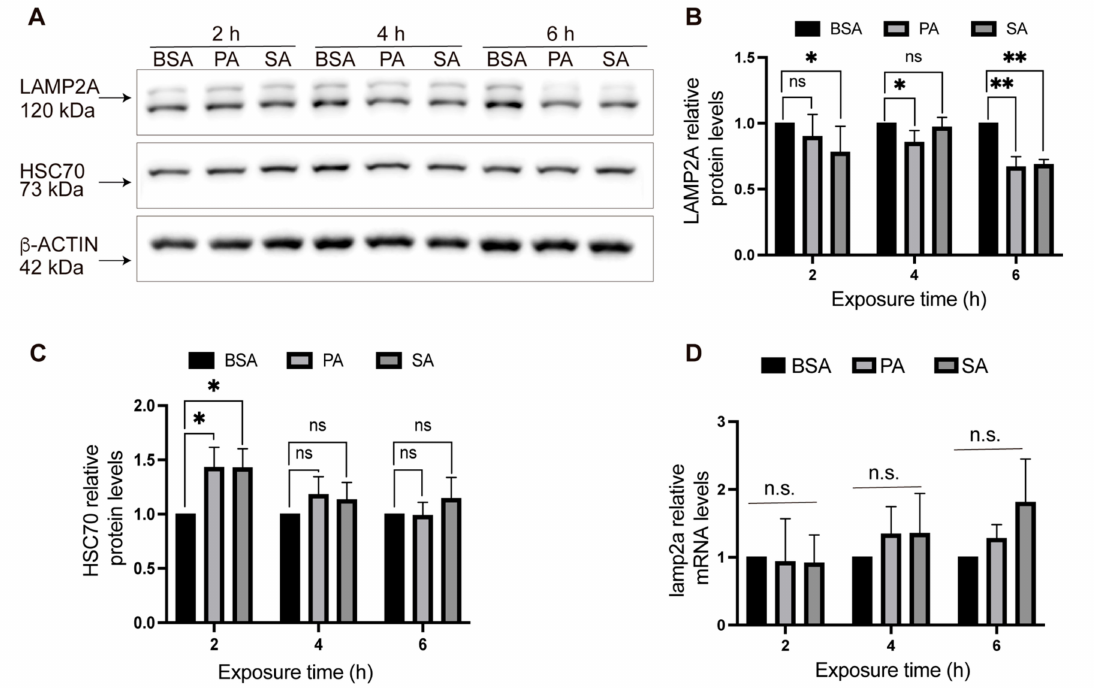
Figure 1. Total LAMP2A protein levels decrease in POMC-like neurons treated with PA and SA. ( A ) POMC-like neurons (N43/5) were incubated with 100 mM of PA, SA, or vehicle (BSA) for 2, 4, and 6 h and the total protein levels of LAMP2A, HSC70, and β -ACTIN were evaluated by Western blot. ( B ) Quantification of LAMP2A from Figure 1A where each time point was analyzed independently (e.g., BSA vs. PA at 2 h) using the Kolmogorov–Smirnov nonparametric t -test ( n = 4). ( C ) Quantification of HSC70 from Figure 1A where each time point was analyzed independently (e.g., BSA vs. PA at 2 h) using the Kolmogorov–Smirnov nonparametric t -test ( n = 4). ( D ) POMC-like neurons (N43/5) were incubated with 100 mM of PA, SA, or vehicle (BSA) for 2, 4, and 6 h and the total mRNA levels of lamp2a were evaluated by RT-qPCR. The data were analyzed by